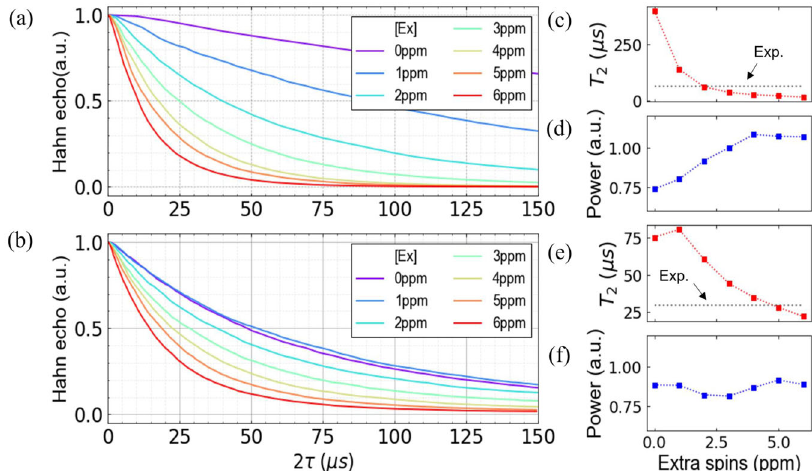
Fig. 3 NV decoherence in a P1 bath with extra electron spins. a , b Computed Hahn-echo coherence of NV ensembles for [P1] = 1 ppm ( a ) and 5 ppm ( b ) with varying extra spin concentrations ([Ex]) from 0 to 6 ppm. c , d T 2 times ( c ) and stretched exponential parameter ( d ) of the NV coherence as a function of [Ex] for [P1] = 1 ppm. e , f T 2 times ( e ) and stretched exponential parameter ( f ) of the NV coherence as a function of [Ex] for [P1] = 5 ppm. In ( c , e ), the black dotted line shows an experimental T 2 time of 65 µs and 30 µs for [P1] = 1.5 ppm and 6 ppm, respectively, taken from the reference 29